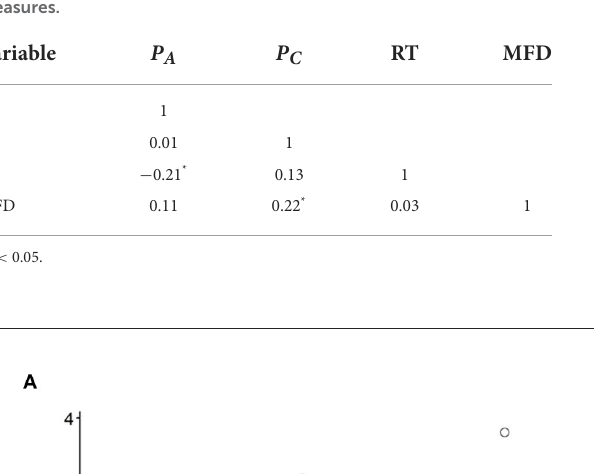
TABLE 1 Correlation coefficient matrix of PDP scores and cognitive measures.